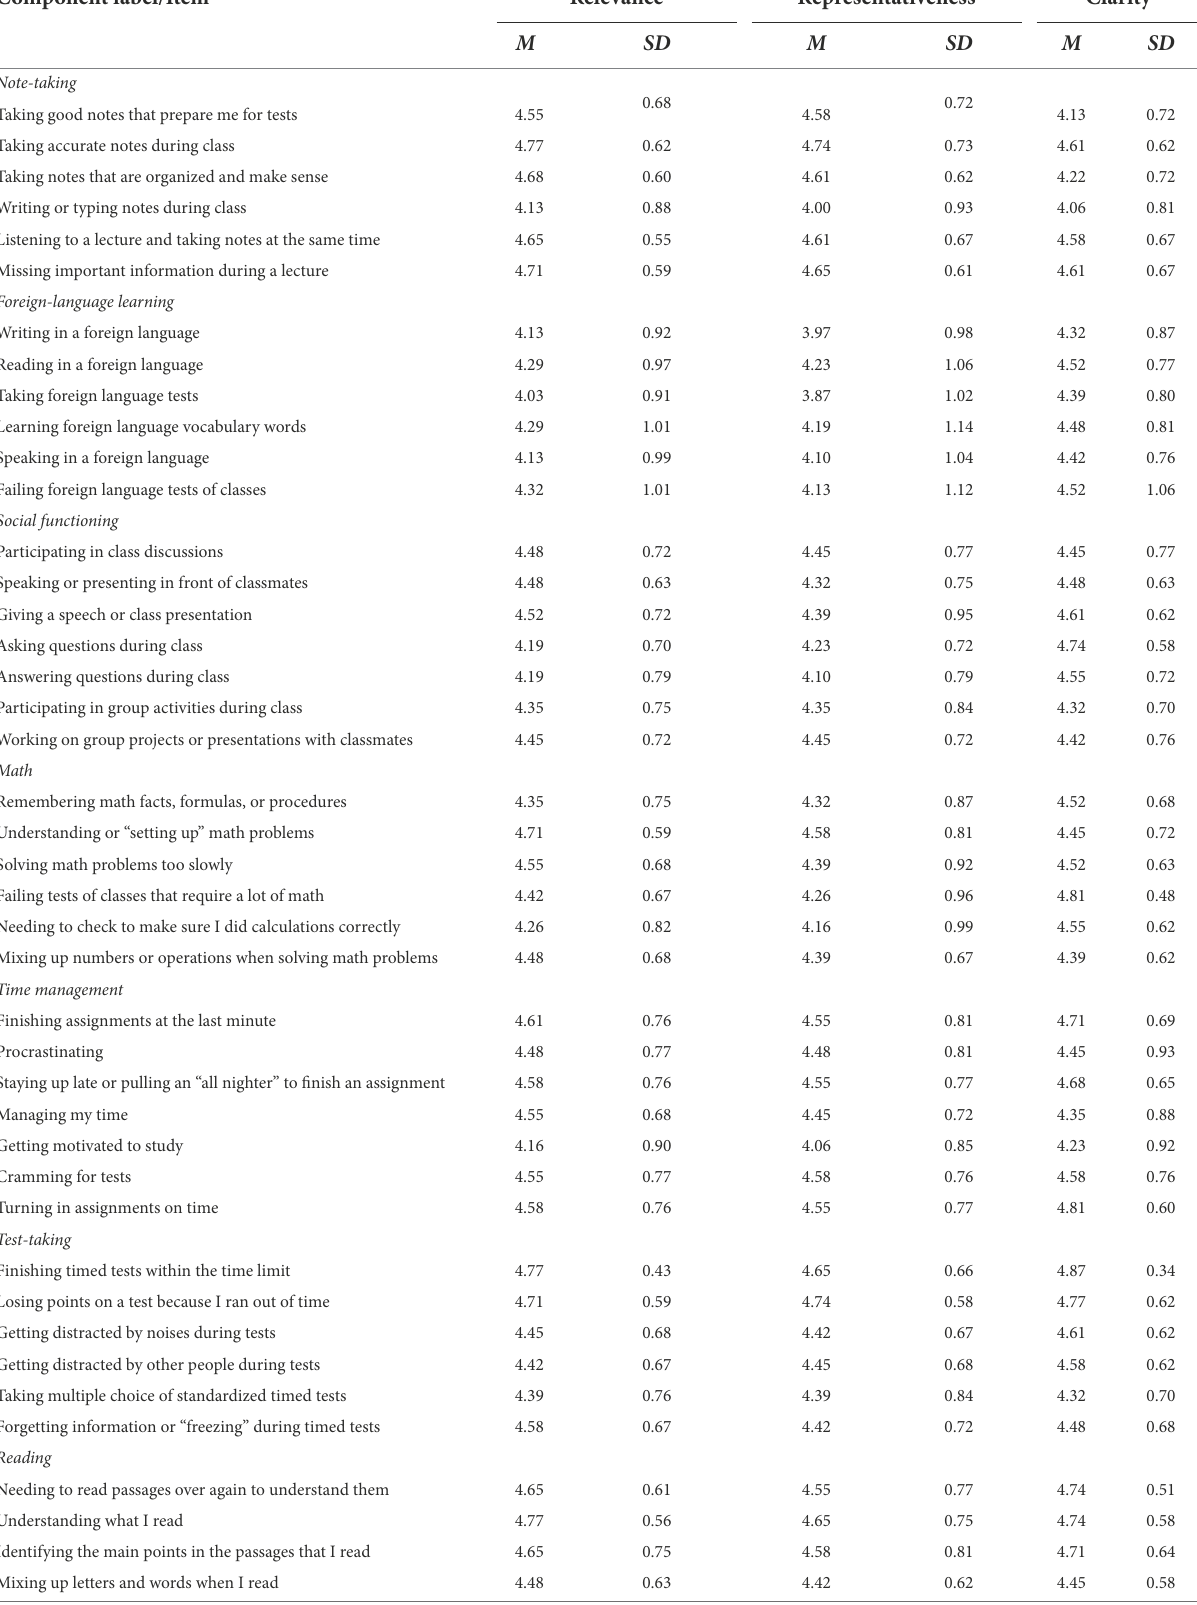
TABLE 4 Content validity ratings by disability support